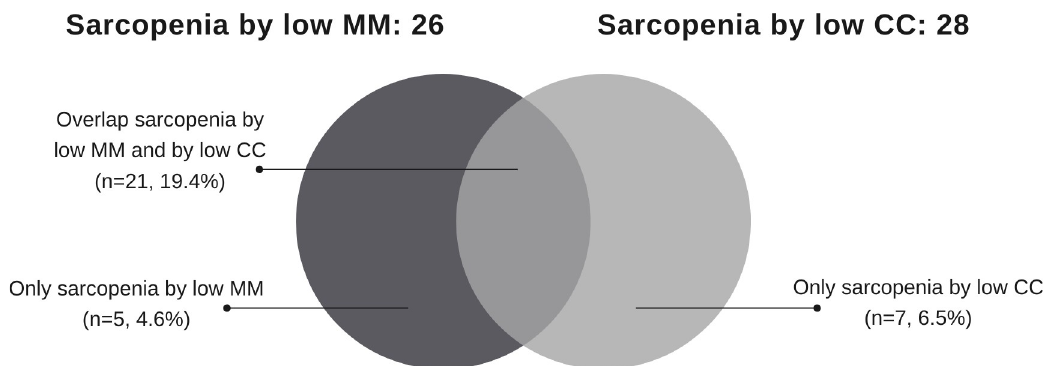
Fig 1. Concordance of individual cases identified by European Working Group on Sarcopenia in Older People 2 (EWGSOP2) considering muscle mass (MM) evaluated by computed tomography (sarcopenia by low MM) and by calf circumference (CC) (sarcopenia by low CC).